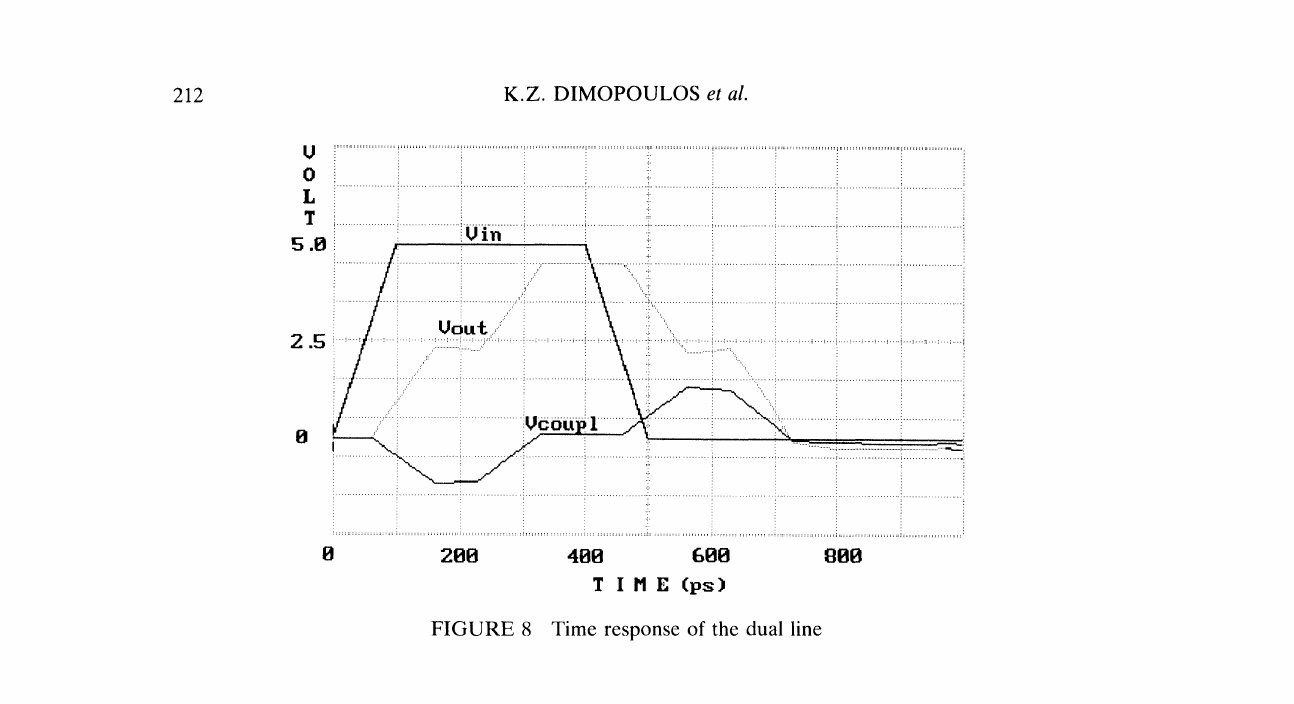
FIGURE 8 Time response of the dual line